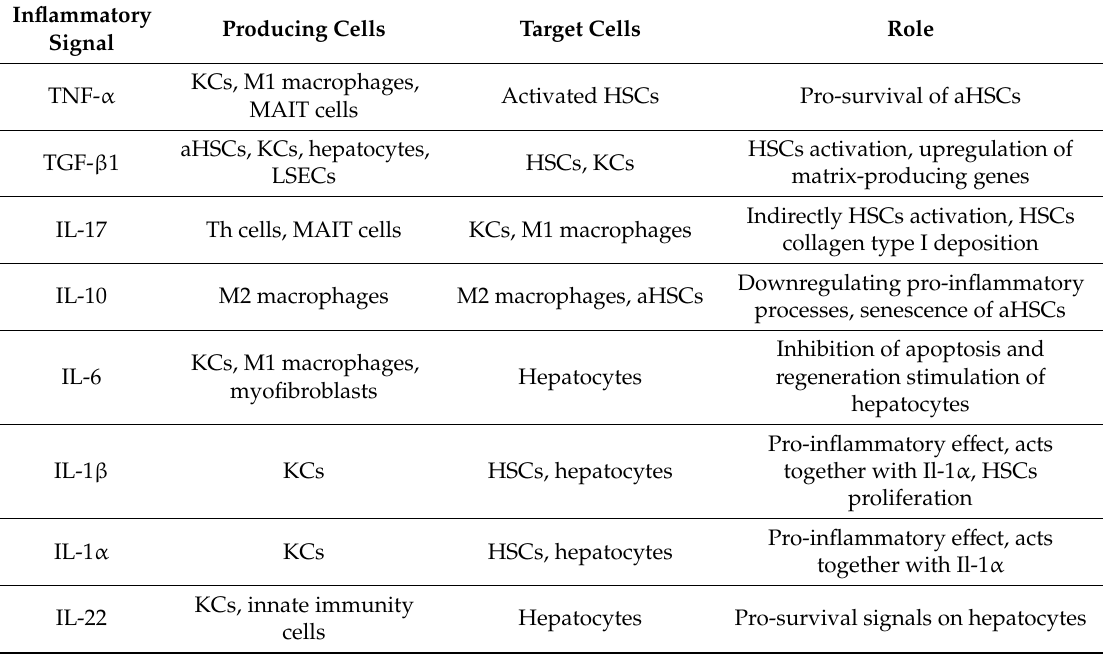
Table 2. Inflammatory cytokines involved in liver